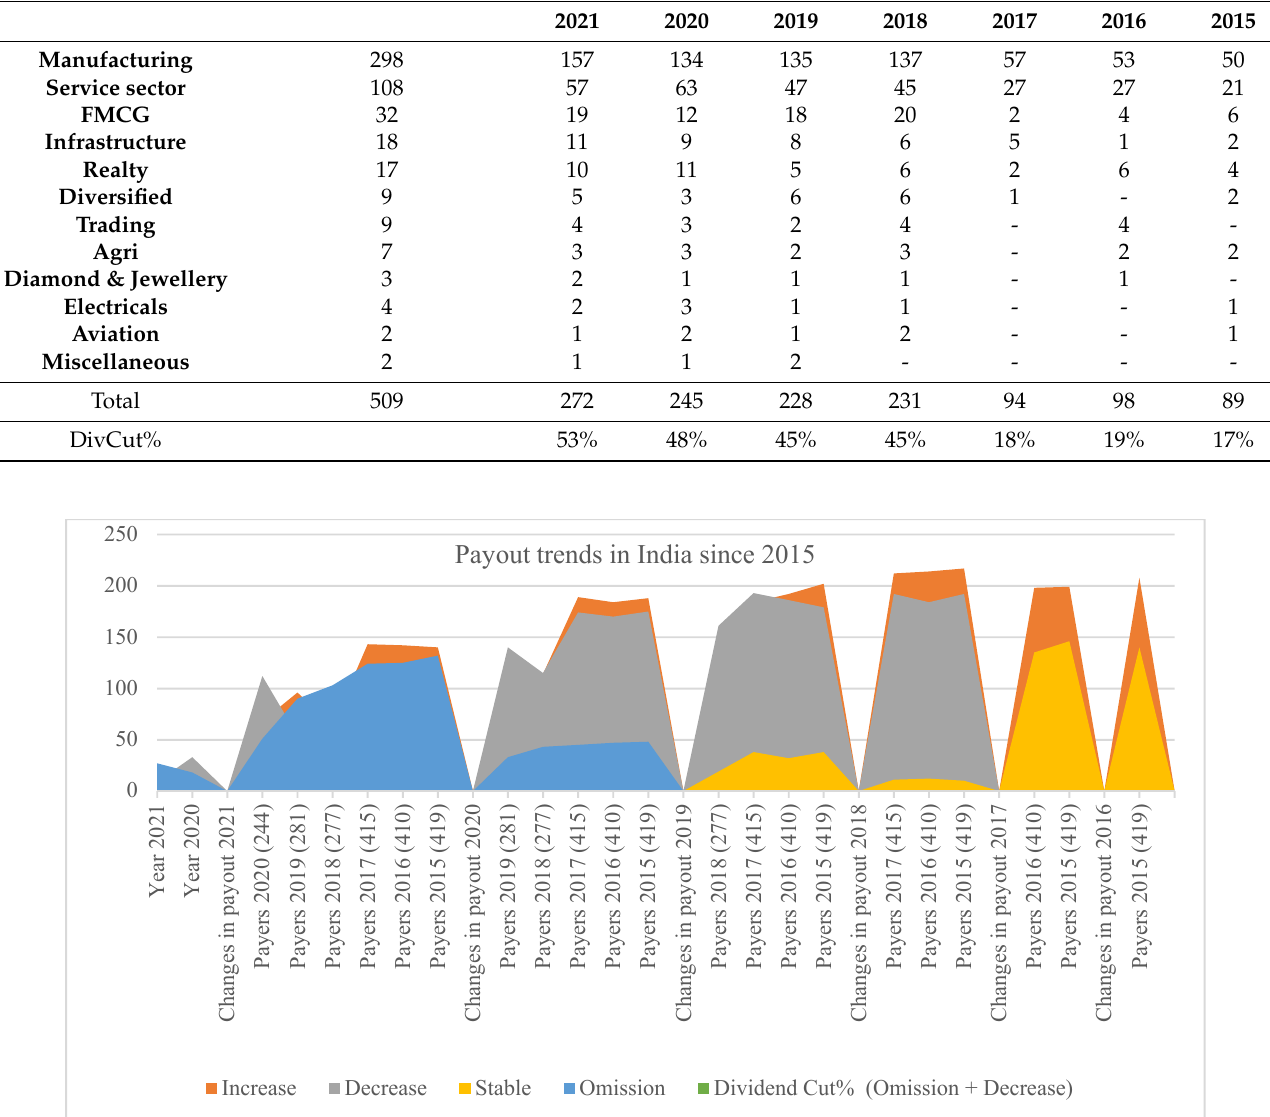
Table 5. Dividend cut trends (2015) onwards across sectors.